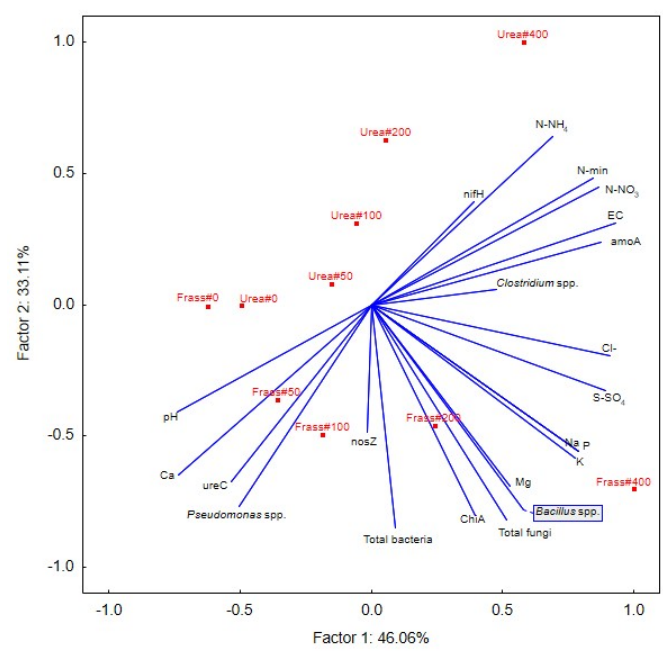
Figure 4. PCA biplot.